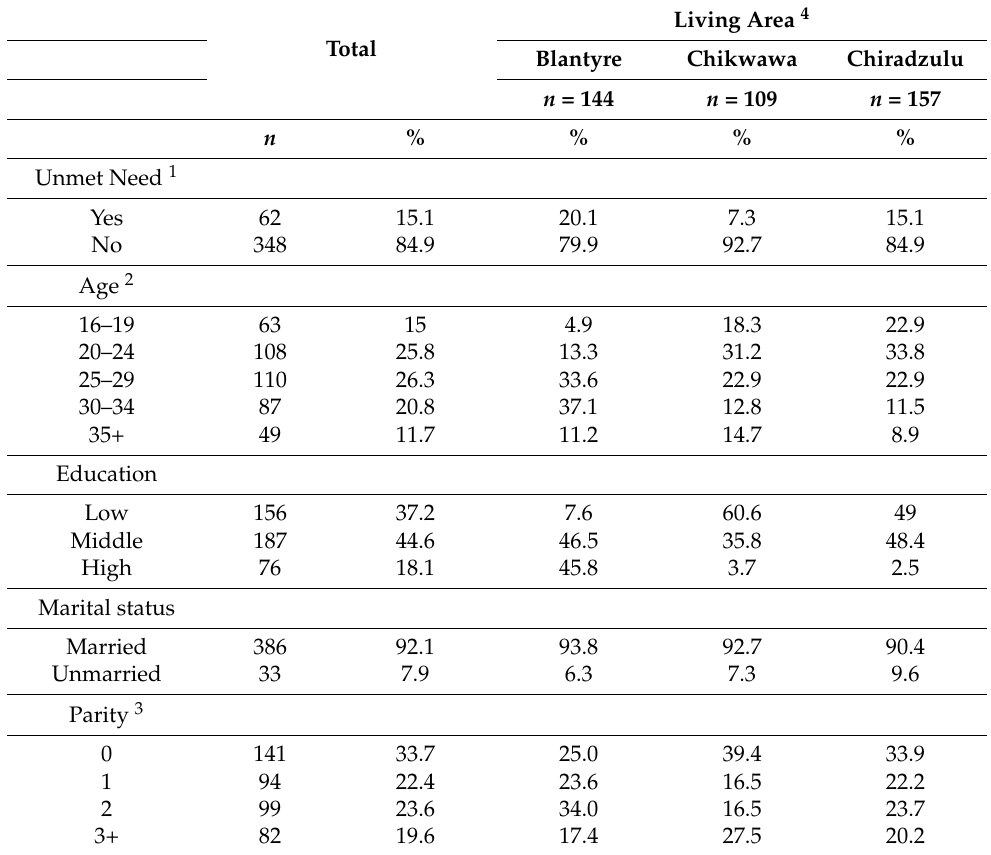
Table 1. Characteristics of pregnant women ( n = 419) attending antenatal clinics at three hospitals in southern Malawi. Living Area 4 Total Blantyre Chikwawa